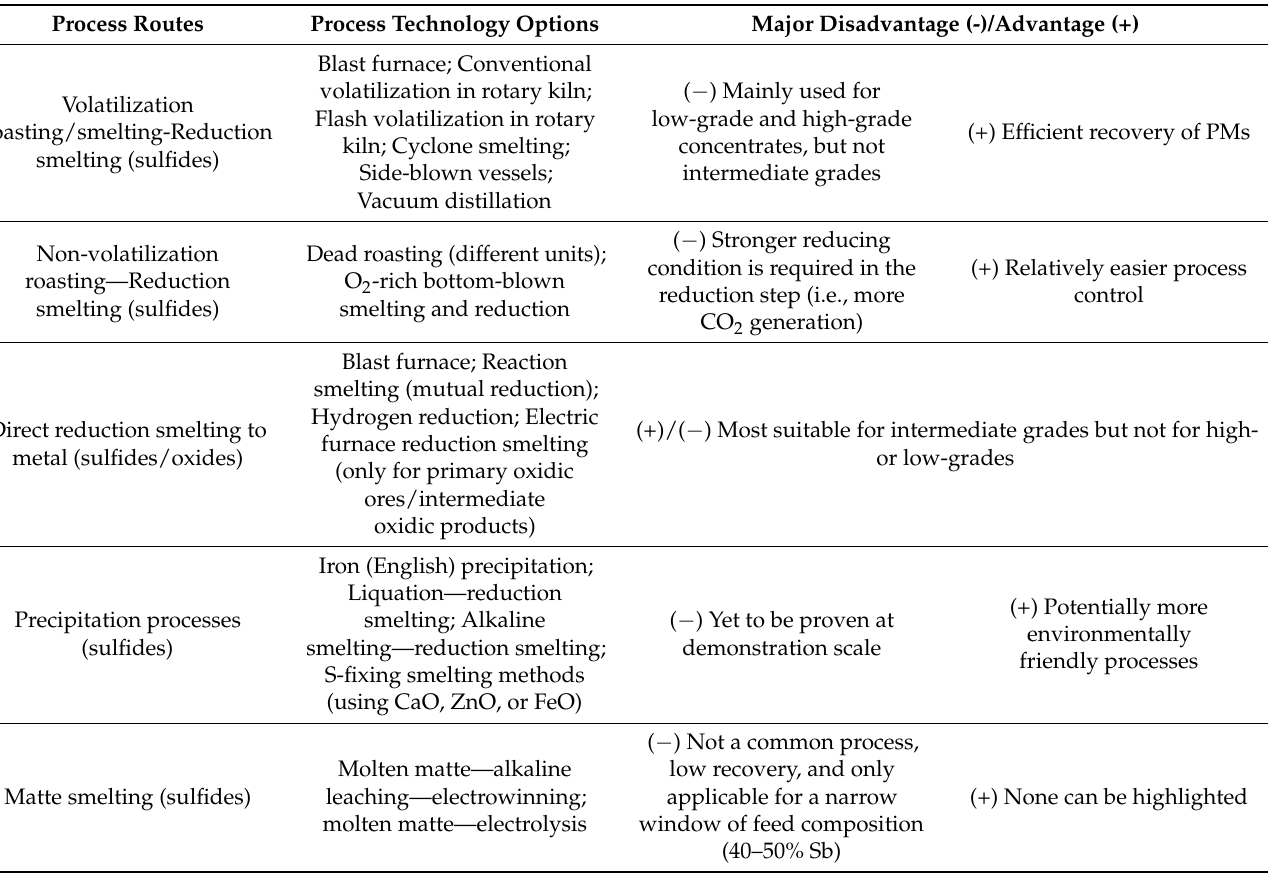
Table 8. Classification of pyrometallurgical processes for antimony production from concentrates.